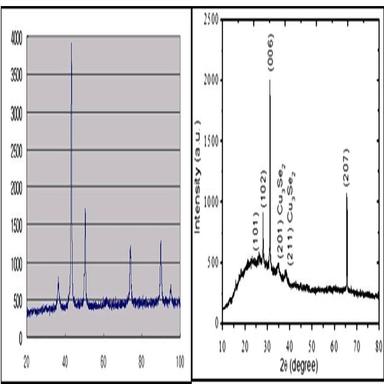
X-Ray diffractogram of Cu and Cu-Se heterostructures showing different peaks.